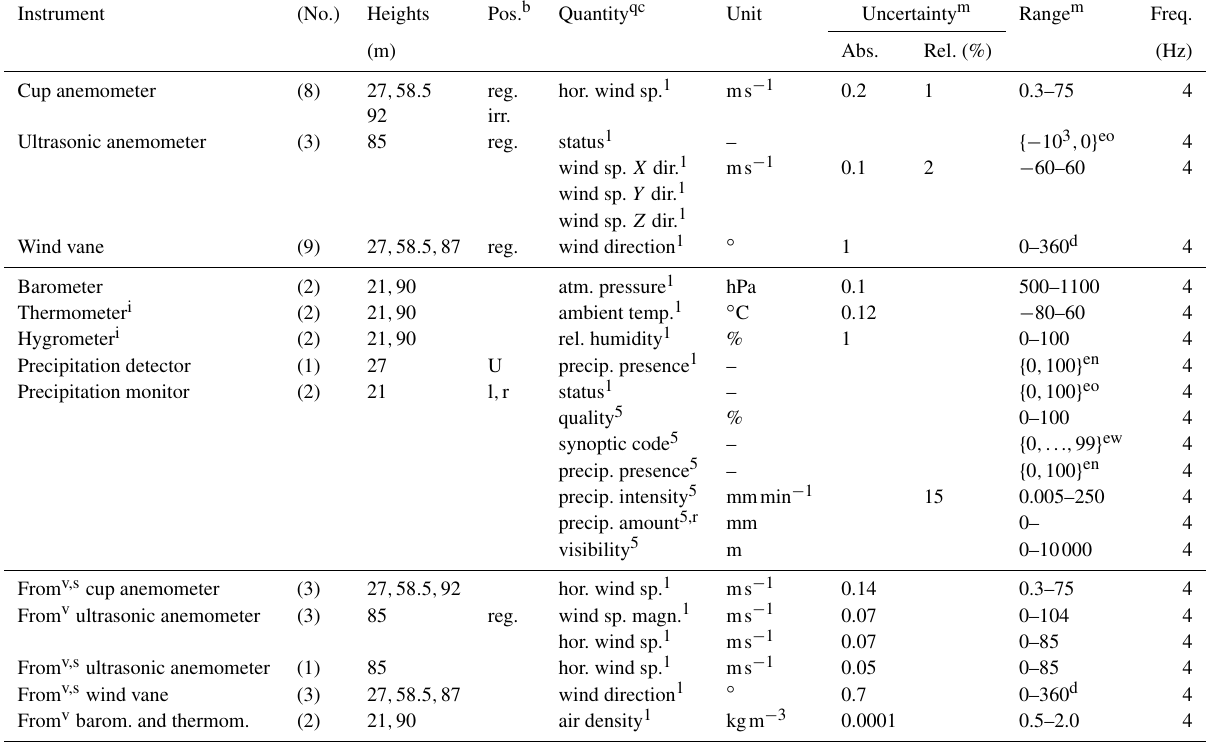
Table A1. An overview of the instruments and their locations on the MMIJ met mast (height in meters above the Lowest Astronomical Tide), the quantity measured, the measurement uncertainty, the measurement ranges, and the sampling frequencies. Instrument (No.) Heights Pos. b Quantity qc Unit Uncertainty m Range m Freq. (m) Abs. Rel. (%) (Hz) Cup anemometer (8) 27 , 58 . 5 reg. hor. wind sp. 1 ms − 1 0.2 1 0.3–75 4 92 irr. Ultrasonic anemometer (3) 85 reg. status 1 –